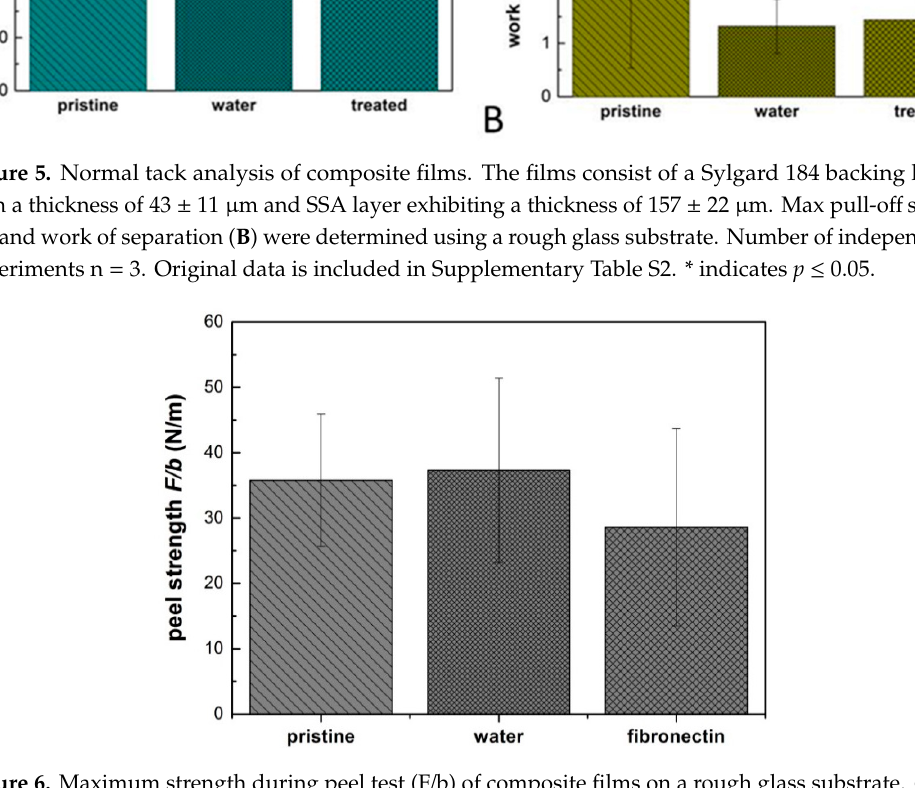
Figure 5. Normal tack analysis of composite films. The films consist of a Sylgard 184 backing layer with a thickness of 43 ± 11 µm and SSA layer exhibiting a thickness of 157 ± 22 µm. Max pull-off stress ( A ) and work of separation ( B ) were determined using a rough glass substrate. Number of independent experiments n = 3. Original data is included in supplementary Table S2. * indicates p ≤ 0.05.